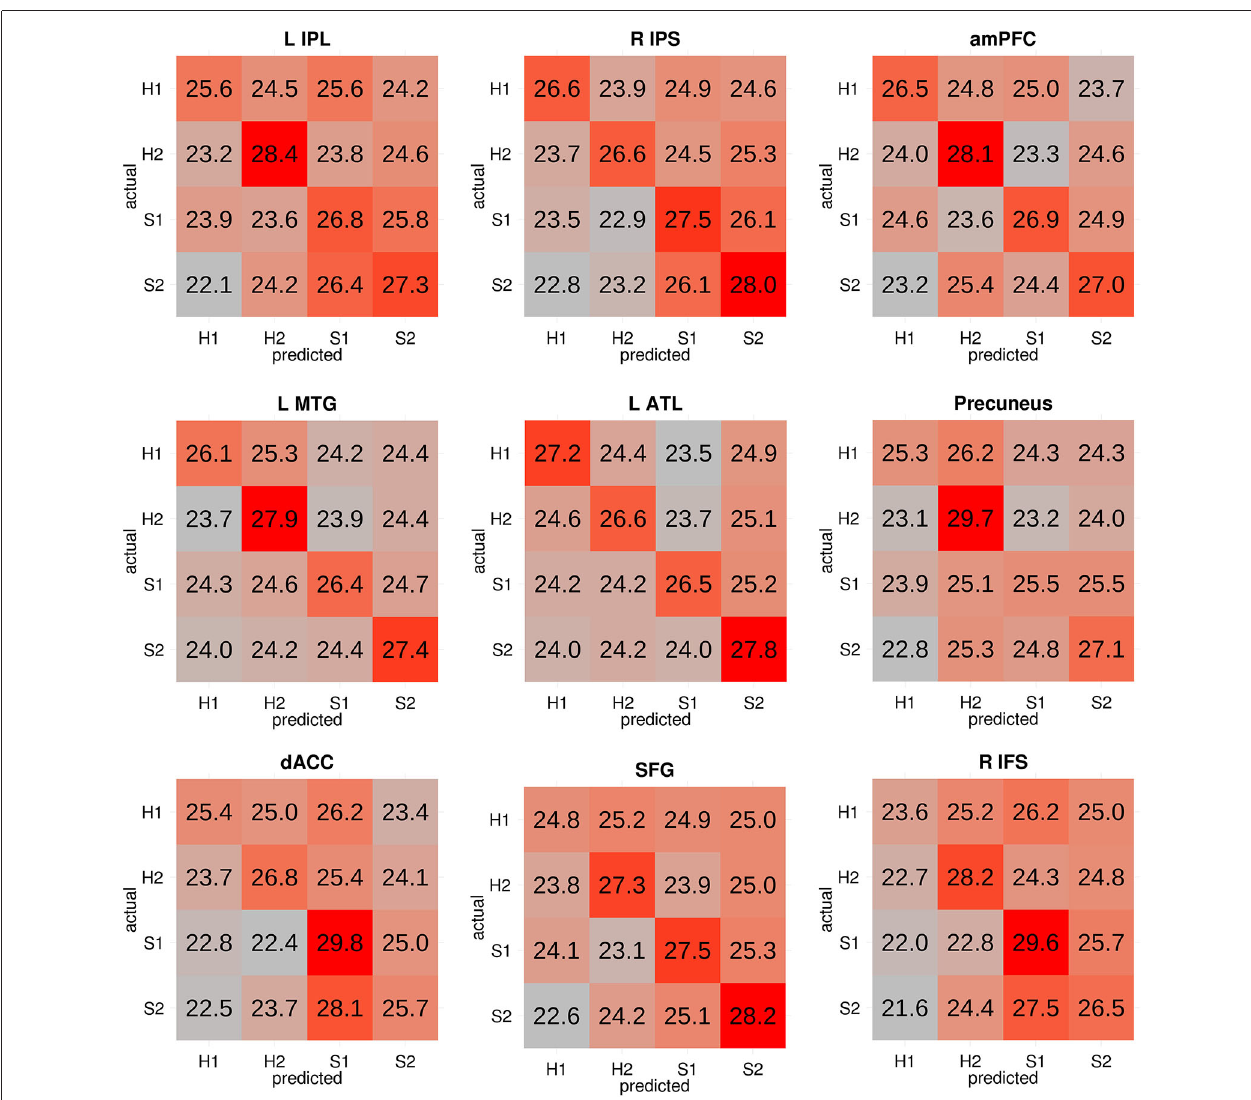
FIGURE 3 | Confusion matrices from each significant cluster from the four-way classification. Each cell reflects the group-level proportion of each type of trial (in rows) that were classified as each of the four types of trials (in columns). The cells in each row therefore add up to 100 (or approximately 100 due to rounding). Cells are colored according to a gradient ranging from the lowest (gray) to highest numbers (red). Successful classification of all four categories is reflected through strong red colors in the diagonal from top left to bottom right. The first five regions (i.e., L IPL, R IPS, amPFC, L MTG, and L ATL) had confusion matrices in which the diagonal elements had the highest numerical value in each row. H1: John-happy, H2: Alex-happy, S1: John-sad, S2: